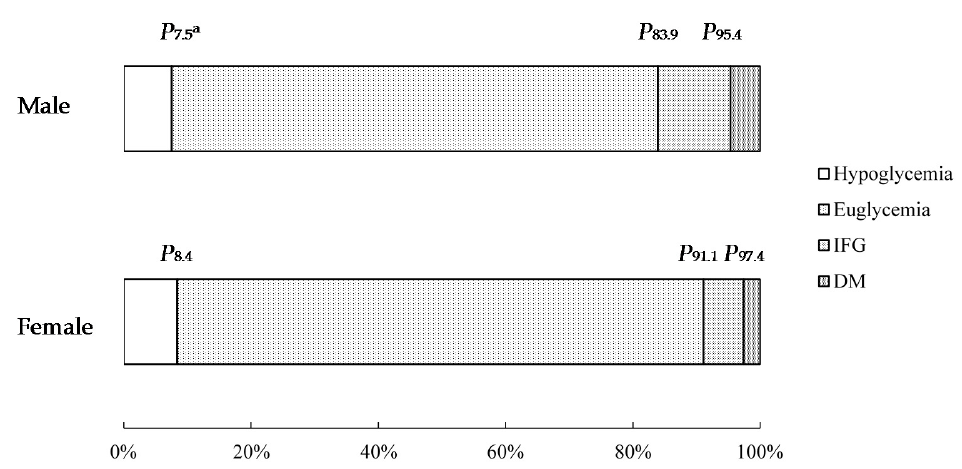
Figure 1. The distribution of FBG for males and females (percentage diagram). ( a P x was used to represent the percentile x; IFG: impaired fasting glycaemia; DM: diabetes mellitus.).